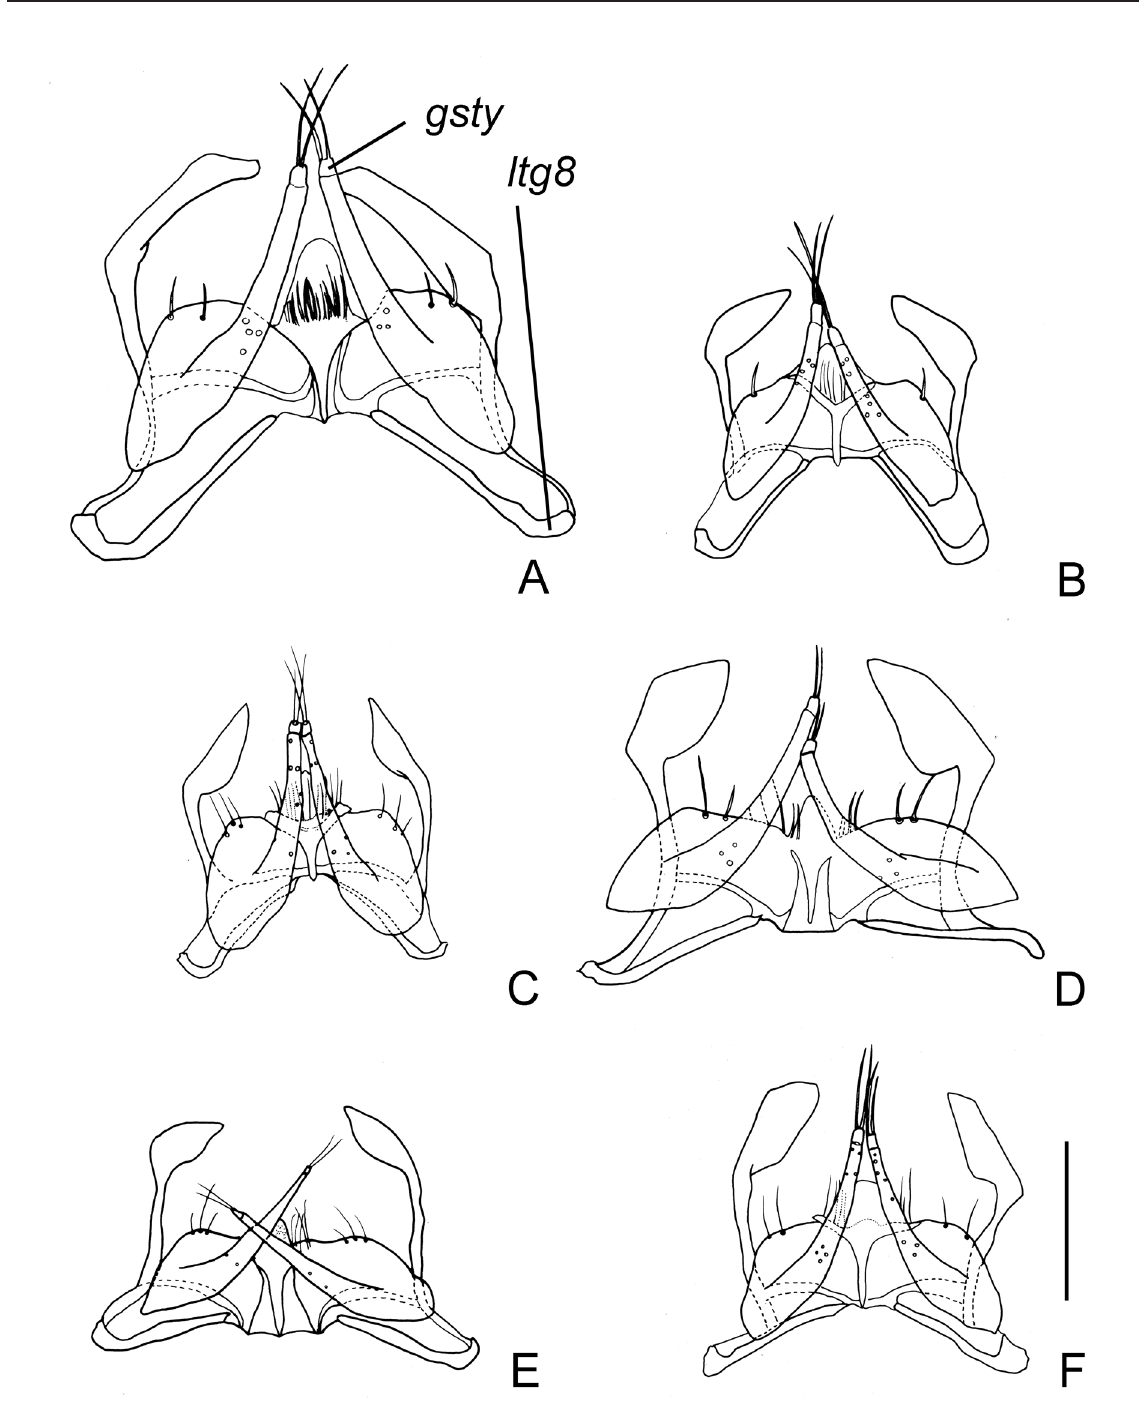
Fig. 10. Female ovipositor of Georissus spp. A . G . ( G .) canalifer Sharp, 1888. B . G . ( G .) babai Satô, 1970. C . G . ( Ne .) japonicus Satô, 1972. D . G . ( Ne .) kurosawai Nakane, 1963. E . G . ( Ne .) takahashii sp. nov. F . G . ( Ne .) satoi sp. nov. Abbreviations: gsty = gonostylus; ltg8 = latero-tergite 8. Scale bar = 0.1